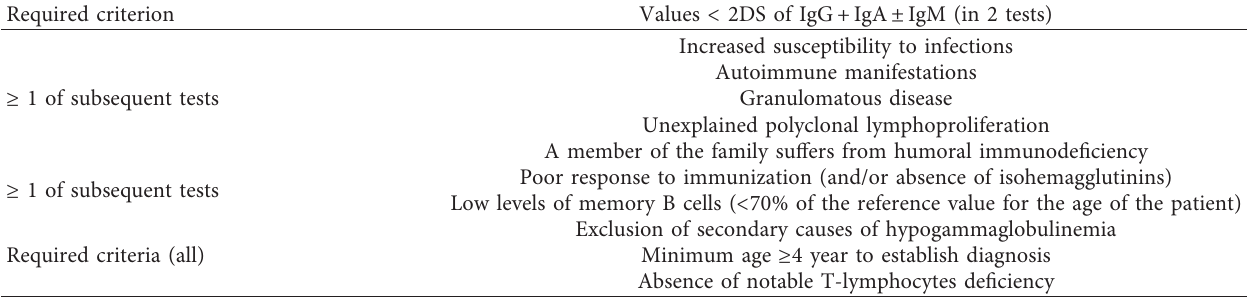
Table 4: Diagnostic criteria for common variable immunodeficiency (modified from Seidel et al.)[32]. Required